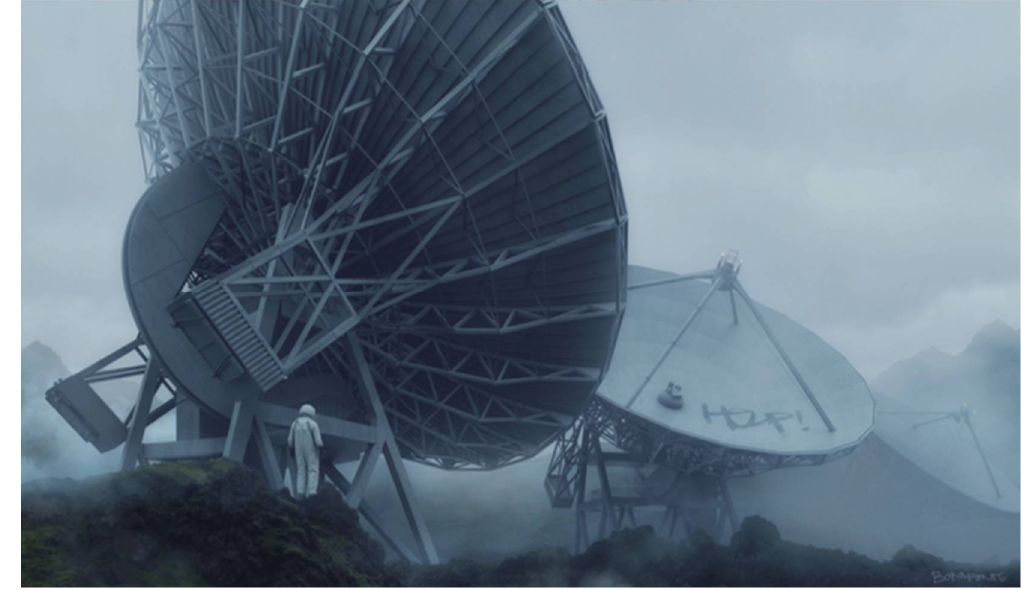
Figura 2. Help Us. Digital matte painting , personal project of Victor